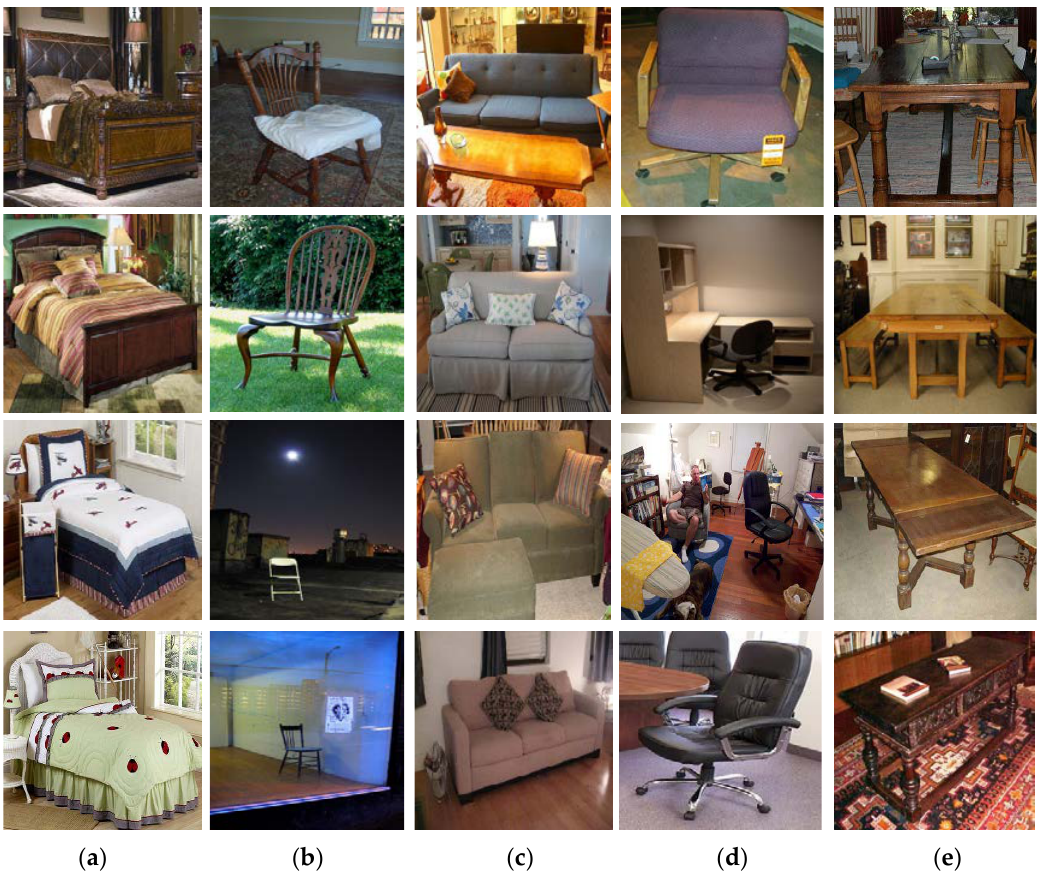
Figure 5. The samples of the furniture dataset. ( a ) bed. ( b ) chair. ( c ) sofa. ( d ) swivelchair. ( e ) table. Table 1. The description of furniture dataset.